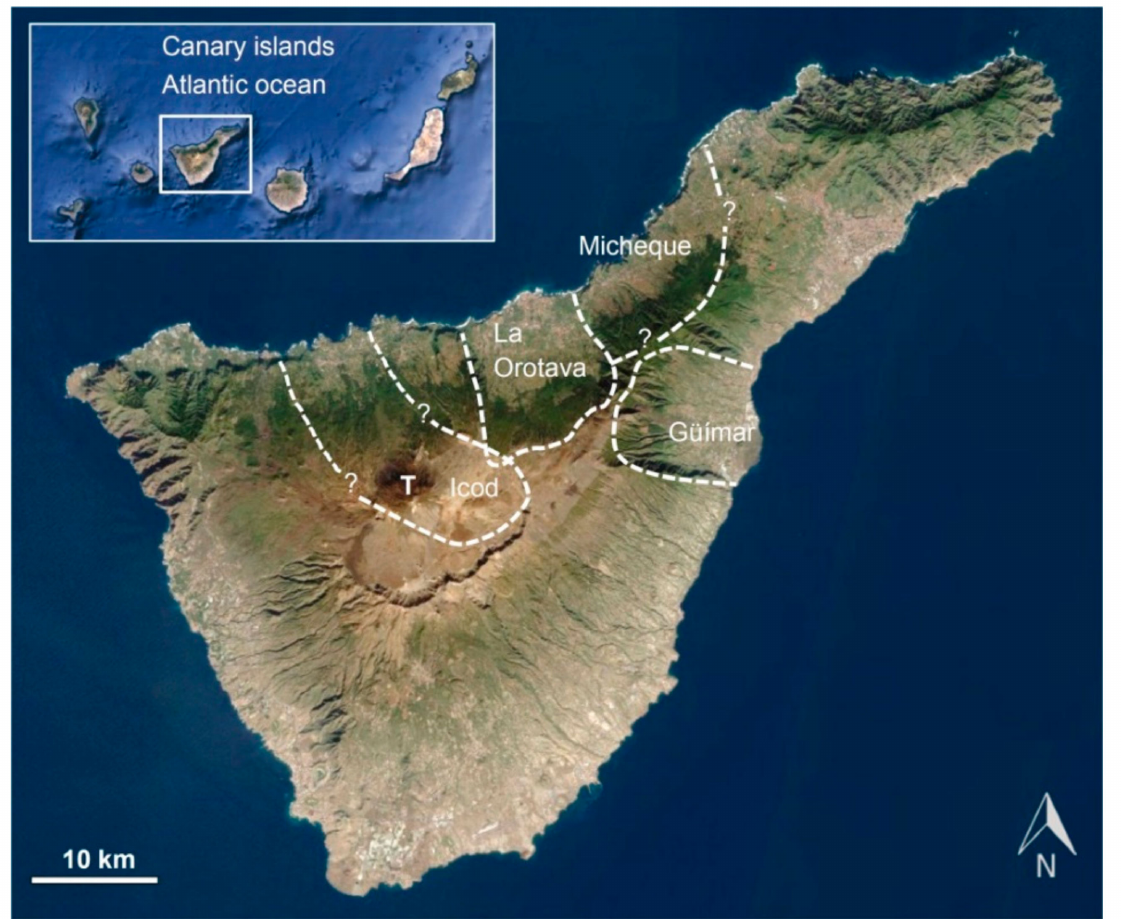
Figure 13. Schematic representation of the most recent landslides in Tenerife: Icod, La Orotava, Gu í mar, and Micheque or Acentejo, the latter without morphological features on surface. T: Teide volcano (3715 m). Limits of Micheque landslide from [76]. Basemap: